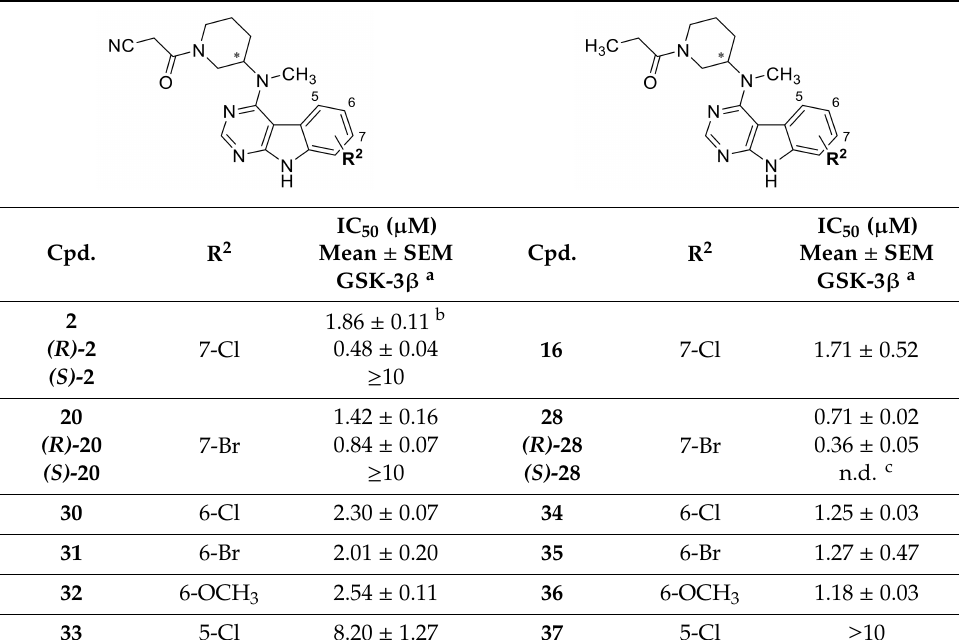
Table 4. Structure and biological activities of compounds 16 and 30 – 37 as well as 2 , 20 , and 28 and their enantiopure